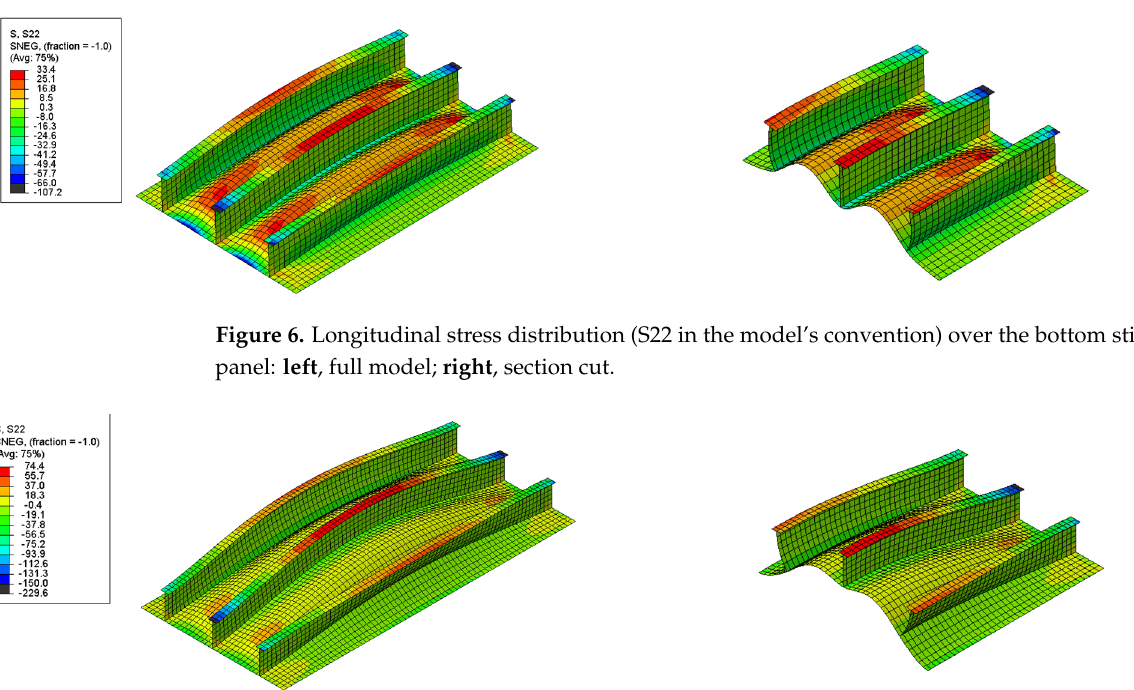
( b ) Figure 5. Modeled geometry with boundary conditions (all degrees of freedom in the boundary, i.e., connection with floors and girders are constrained) and uniformly distributed pressure load (with direction upwards) ( a ) and corresponding mesh ( b ) for the bottom stiffened panel. Figures 6 and 7 present the distribution of the normal bending stress along the stiff- eners’ direction that is produced as a consequence of the pressure load. It is evident that the stress field is almost periodic for the three stiffeners. The middle stiffener is considered the representative one, because it is not that affected by the imposed boundary conditions applied at the edges. Within the unsupported region between the stiffeners, tertiary (plate bending stress field) and secondary stresses are superimposed. Hence it is difficult to sep- arate them. However, it is assumed that the axial bending stress developed at the flange is purely associated with the secondary stress field and unaffected by the tertiary stresses.